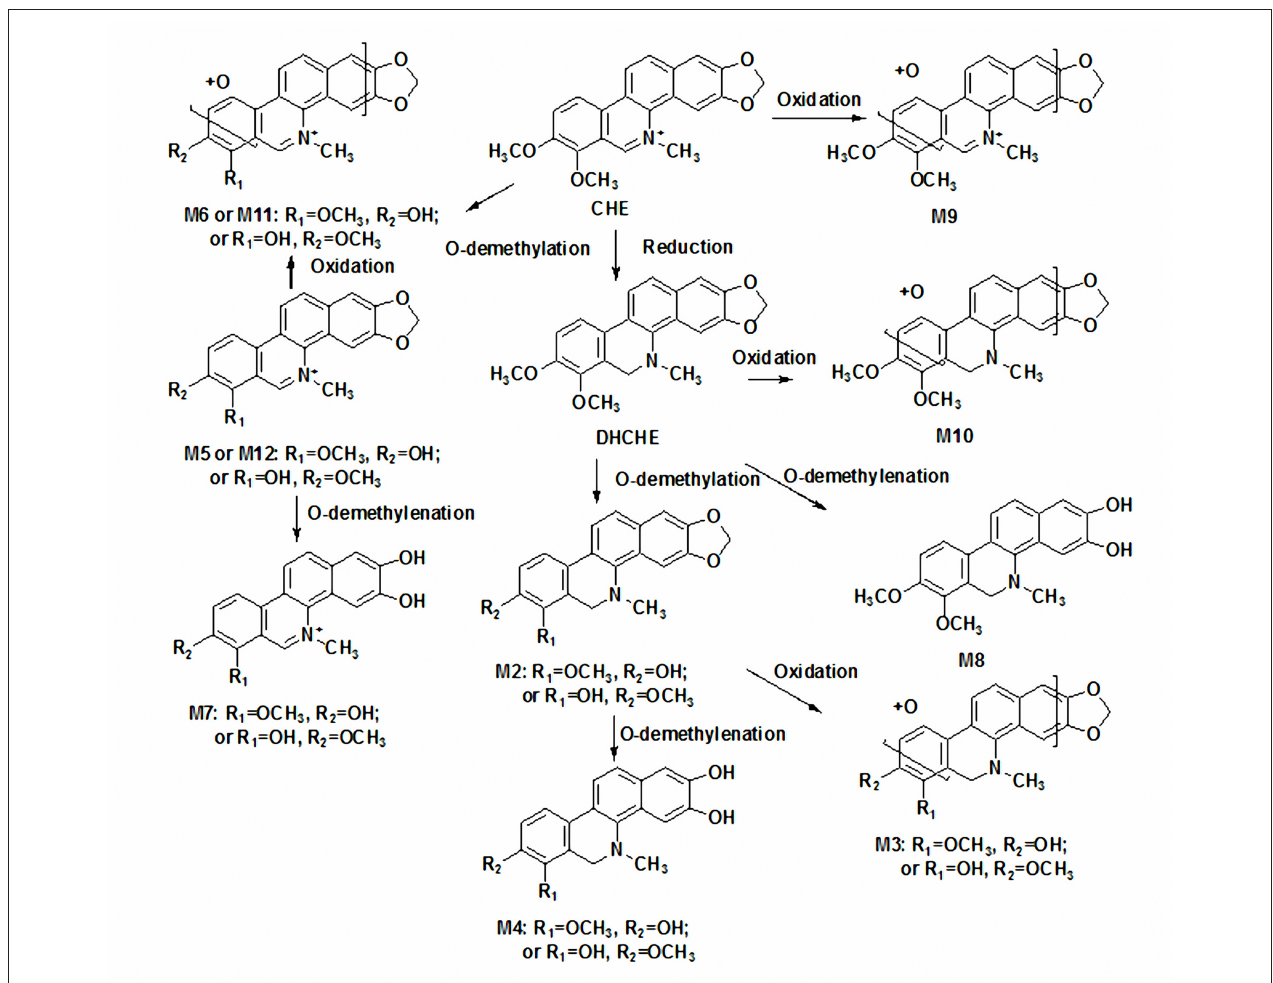
FIGURE 5 | The possible metabolic pathways of chelerythrine in liver S9 and in vivo .